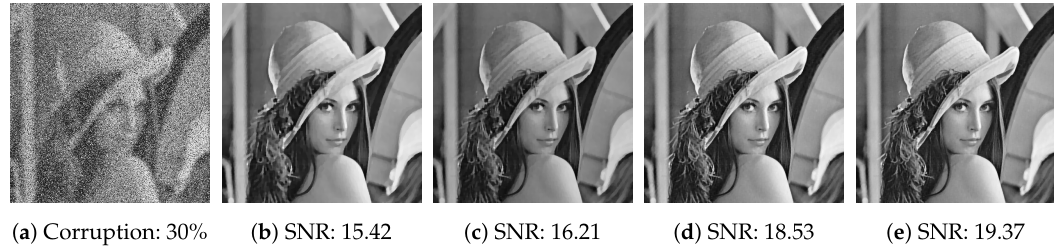
Figure 8. Comparisons of TVL1, HTVL1, CTVL1 and HOCTVL1 model on the Lena image corrupted by Gaussian blur and salt-and-pepper noise with noise level 30%. ( a ) Corrupted image. ( b ) TVL1 model. ( c ) HTVL1 model. ( d ) CTVL1 model. ( e ) HOCTVL1